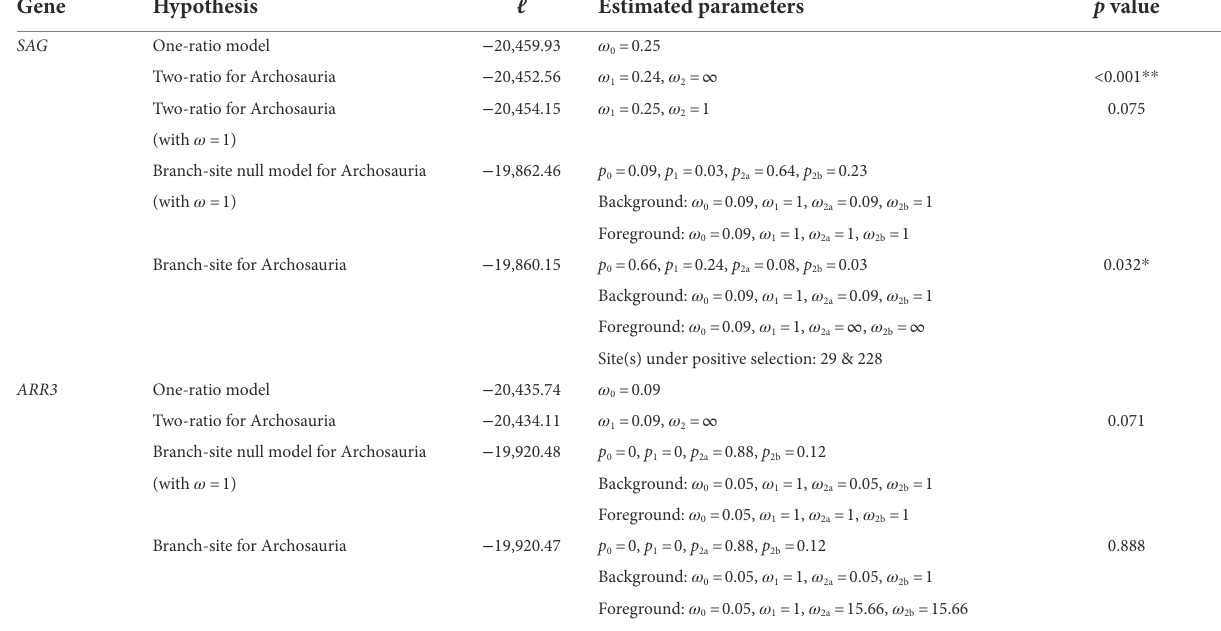
TABLE 2 Tests for selection on archosaur SAG and